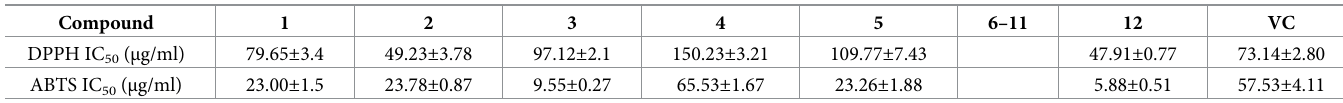
Table 2. Antioxidant activities of phenolic compounds 1–12 a